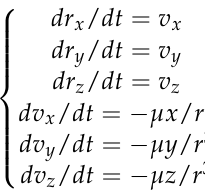
Figure 3. Schematic diagram of the ECI coordinate system.